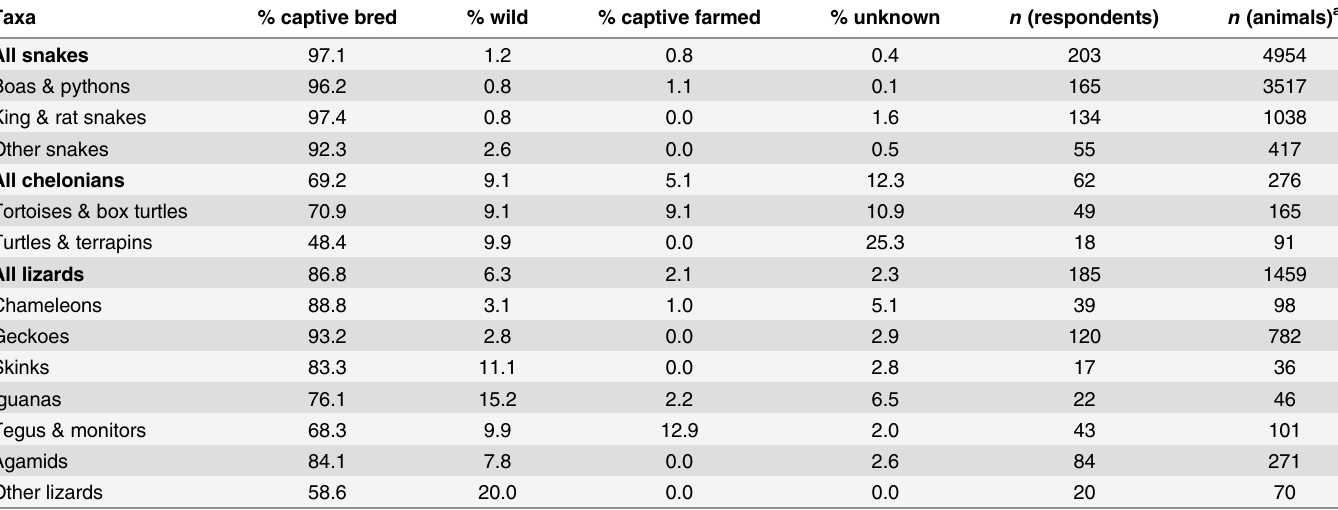
Table 1. Percentage of reptiles acquired over five years preceding the study which were reported by respondents (N = 265) to be captive bred, wild, captive farmed or of unknown origin. Also includes the number of respondents and the total number of individual animals used in the analysis. Taxa